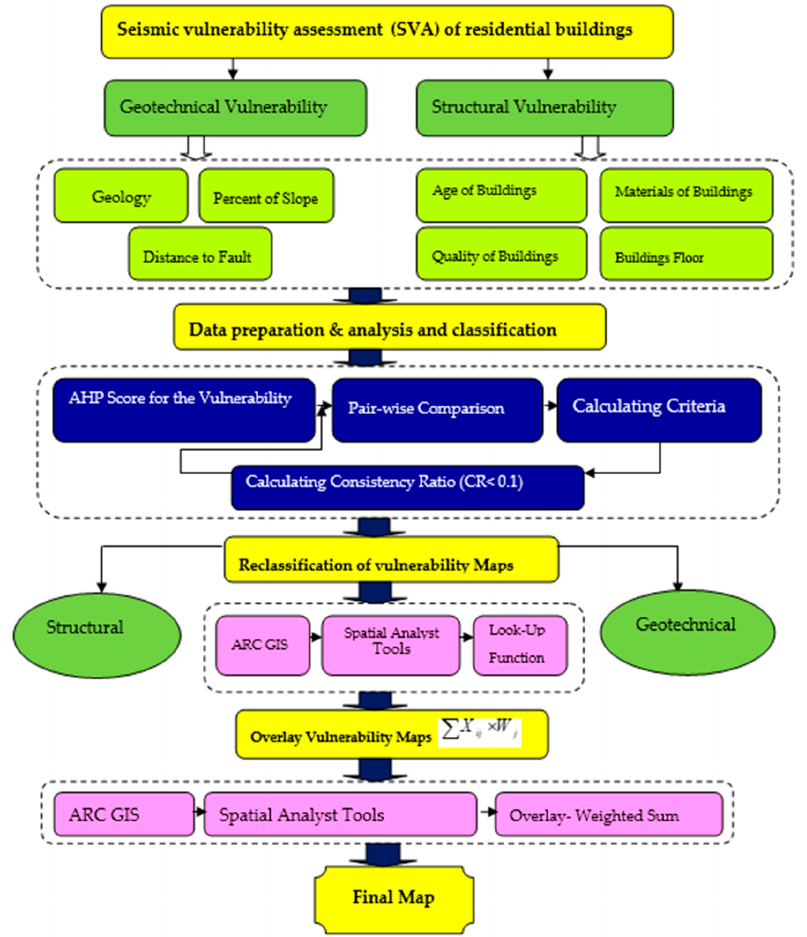
Figure 2. Flowchart of the methodology illustrating the various stages of the analysis for the preparation of the seismic vulnerability map of the study area.